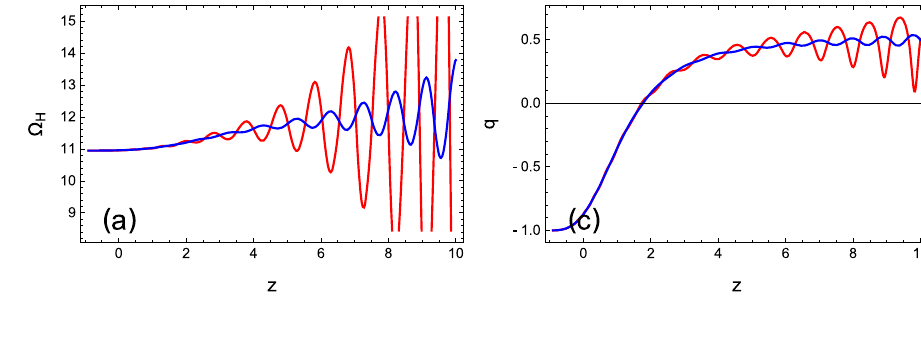
Fig. 7 Solutions for the density parameter Ω H and the deceleration parameter q for the f ( R ) gravity with interaction considering η = 0 . 006 and α = 0 . 9. The red curves correspond to ˜ γ = 10 − 3 and the blue curves correspond to ˜ γ = 0 .